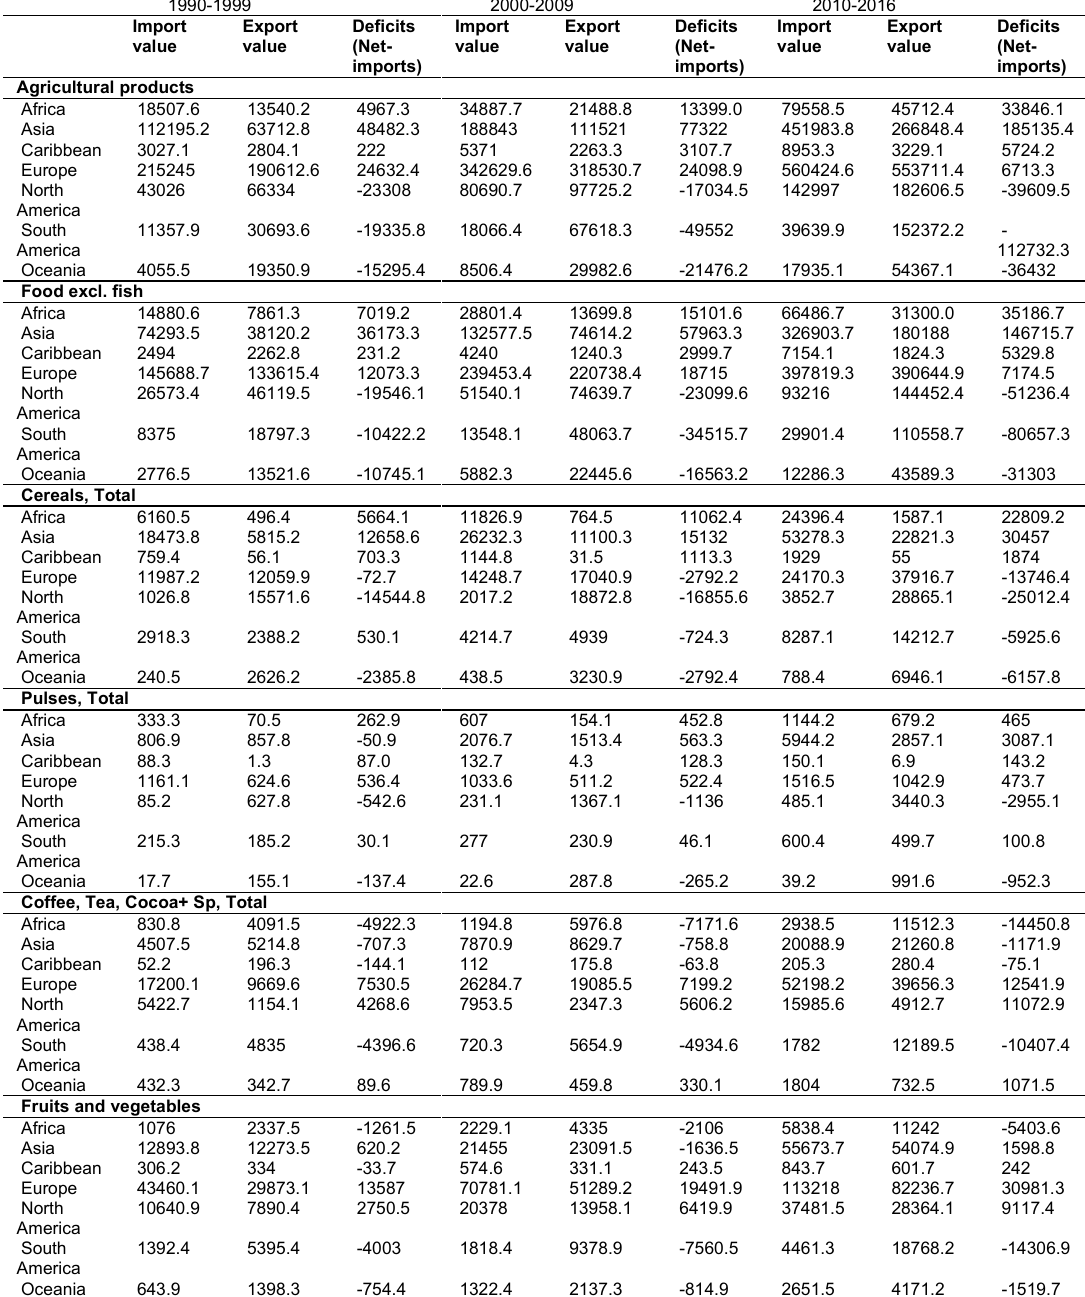
Table A.1 . World food and agricultural products trade balances 1990-2016 (Average value in million US$). Source: Authors’ calculation using FAO